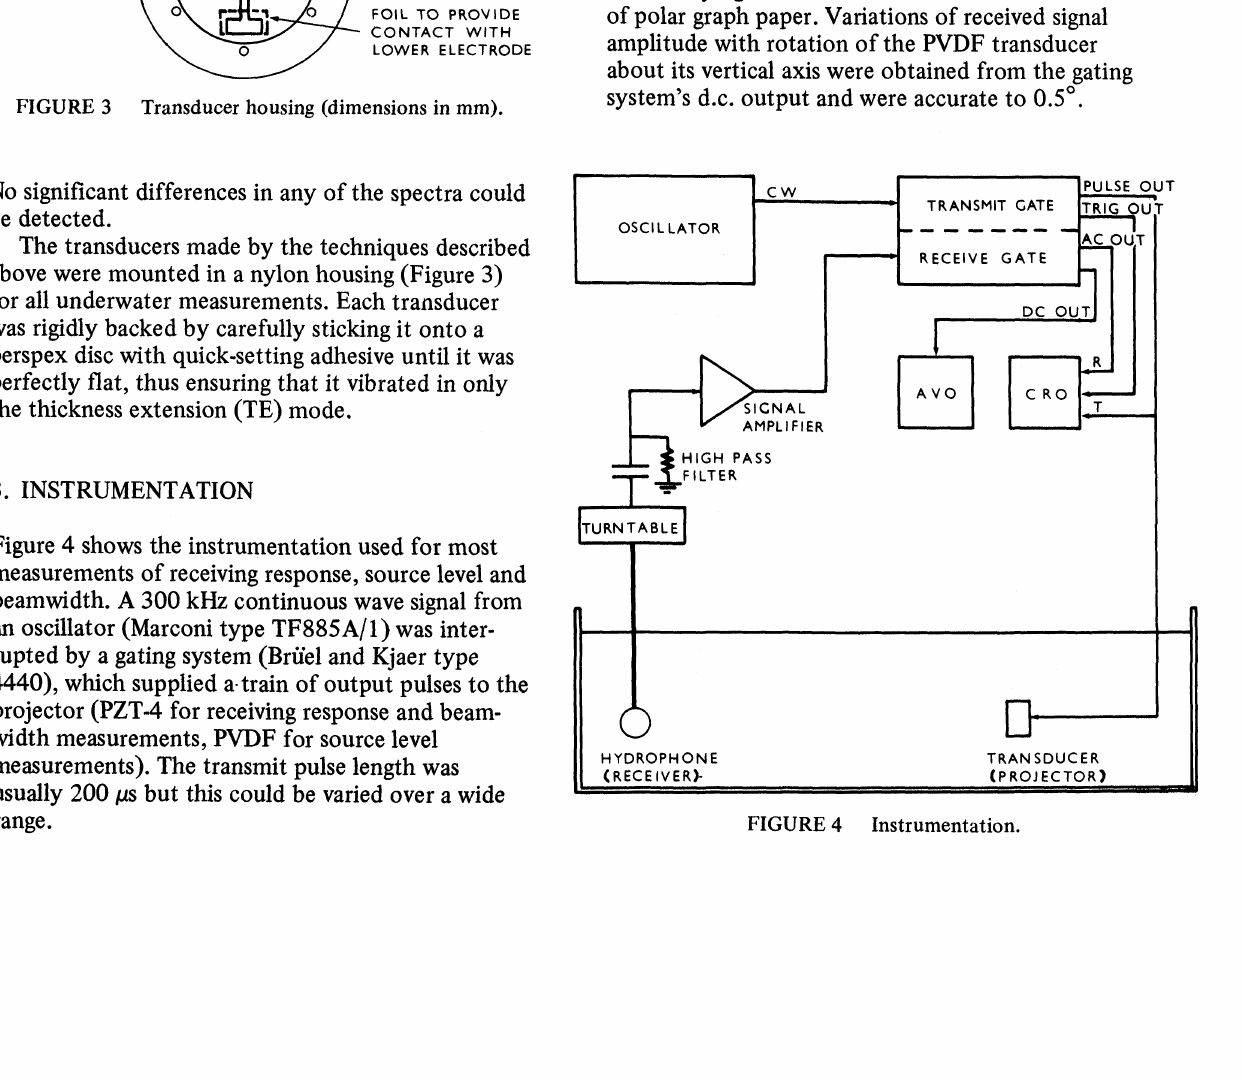
FOI TO PROV DE CONTACT WITH LOWER ELECTRODE